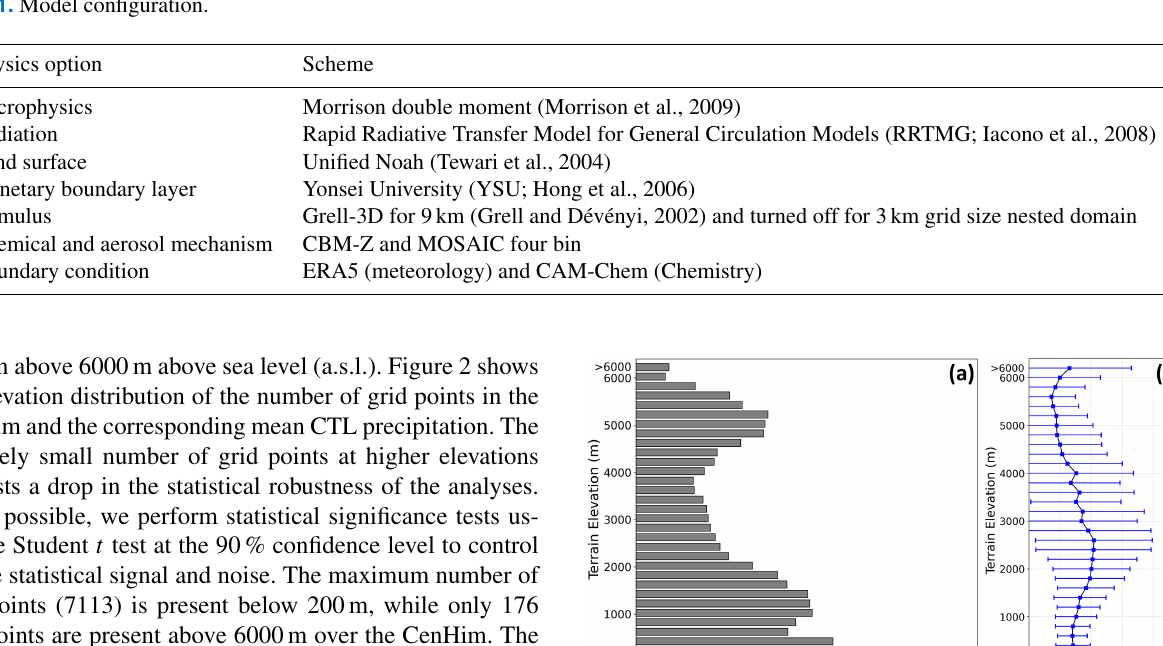
Figure 1. (a) The topography of the 9 and 3km nested grid size domains used in the simulation. The red marker represents the station locations for AERONET (circle) and upper air sounding (triangle). (b) The white-colored polygon represents the central Himalayan region (CenHim) mentioned in the text. The red marker represents the locations of DHM Nepal rain gauge stations. Table 1. Model configuration.